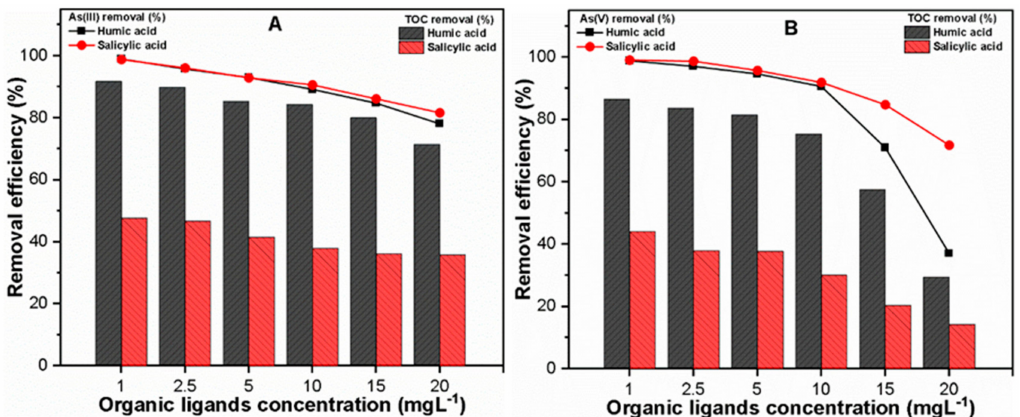
Figure 3. At various organic ligands concentrations, removal e ffi ciencies of ( A ) As(III) and ( B ) As(V) and respective TOC from